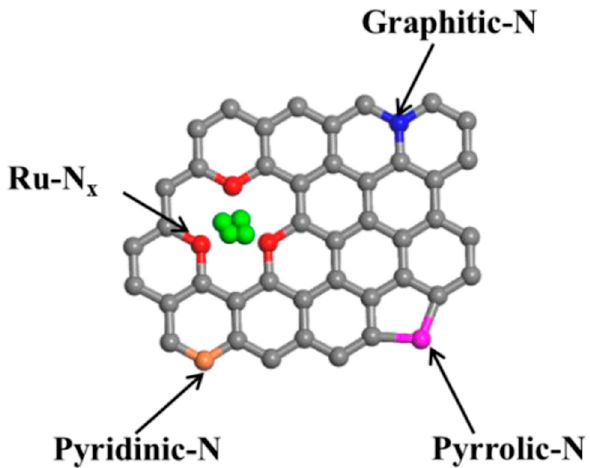
Figure 8. The possible bonding configurations of N atoms. Reprinted with permission from Ref. [202]. Copyright 2019, American Chemical Society.